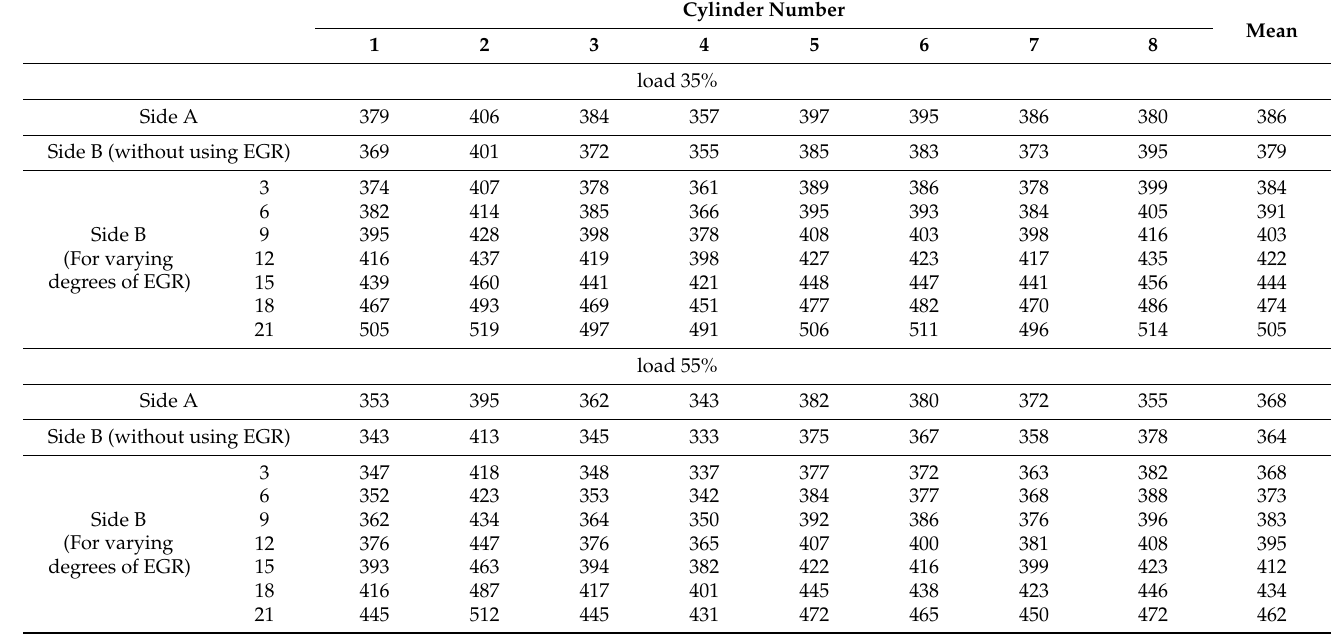
Table 4. Exhaust gas temperature change in the cylinders of a 16V32 STX-MAN marine diesel engine under different experimental conditions (load 35 and